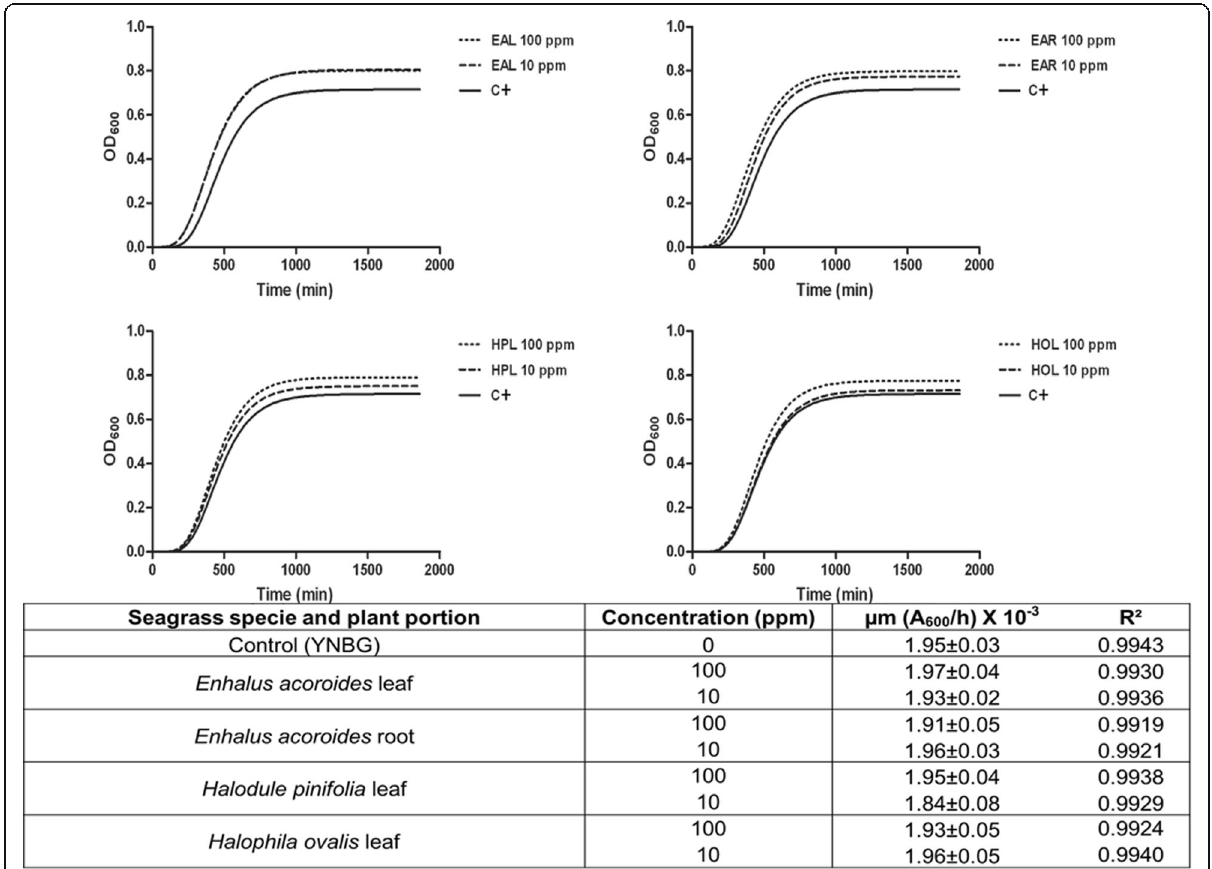
Fig. 5 OD-based growth curves of E. coli in absence (positive control) and in presence of each seagrass extract at 10 and 100 ppm. Maximum specific growth rate ( μ m ) and the goodness of fit (R 2 ) obtained by the Gompertz model. Data represent the mean ± SDs of three independent measurements. Means reported showed no statistically significant differences between the positive control and treated samples (Tukey ’ s HSD, p ≥ 0.05). (EAL = Enhalus acoroides leaf; EAR = Enhalus acoroides root; HPL = Halodule pinifolia leaf; HOL = Halophila ovalis leaf; C + = Positive